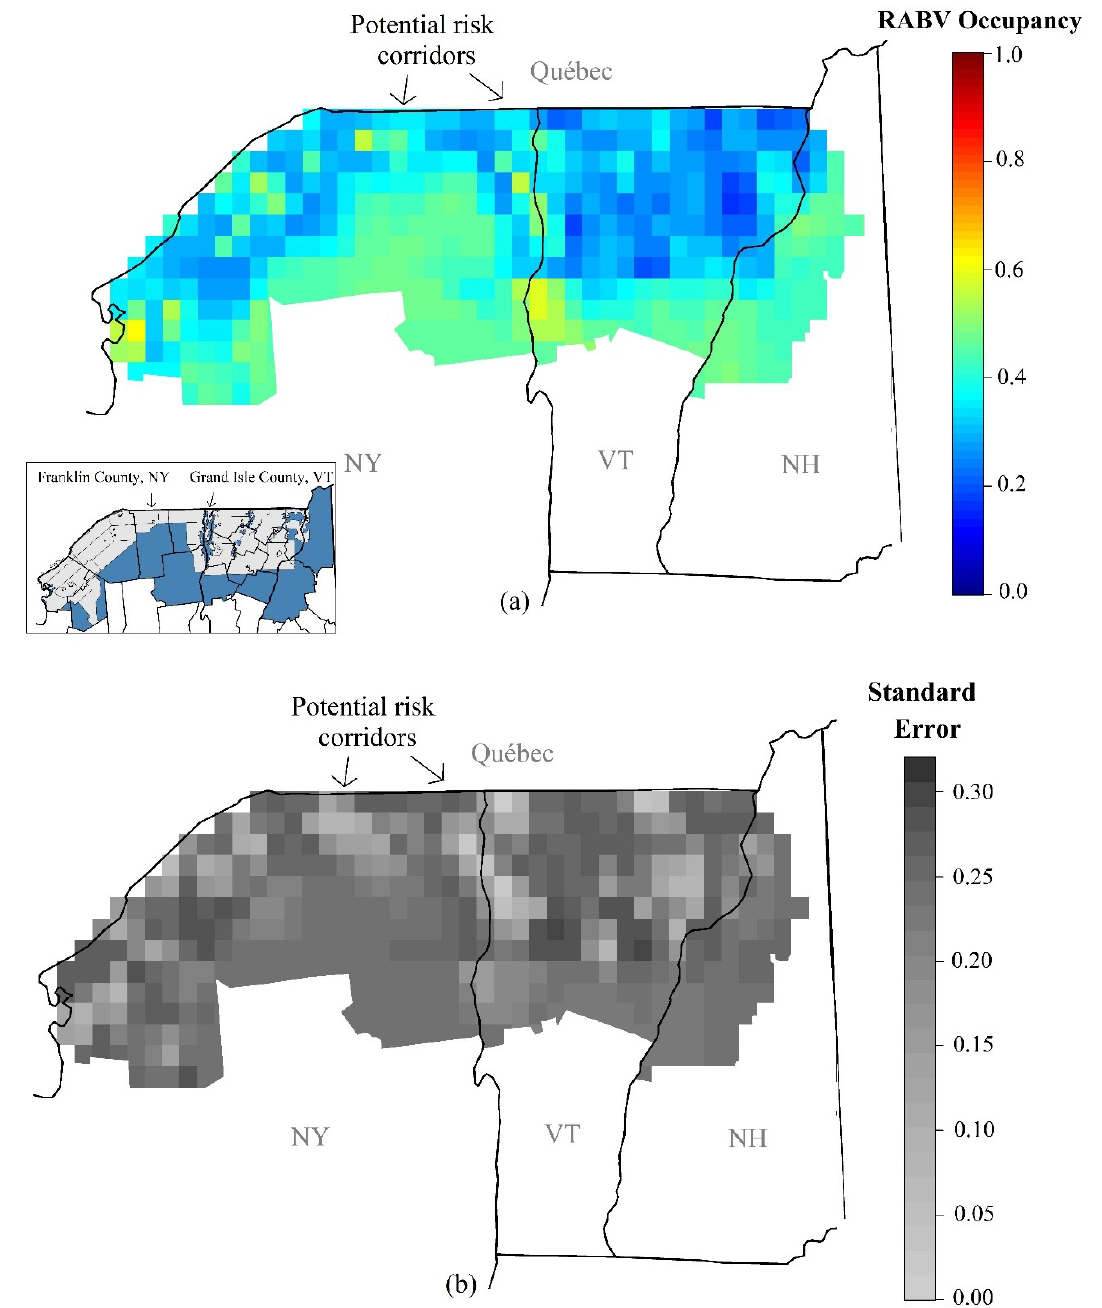
Figure 4. ( a ) The probability of RABV occupancy surface within the study area in the fall of 2017. The inset in this figure shows the county boundaries and the ORV boundaries for 2017 (light grey). ( b ) The standard error around RABV occupancy estimates by grid cell for the fall of 2017. Public health samples comprised the largest percent of all samples tested (30.75%, Table 2). Found dead and surveillance trapped were the smallest percentages of all samples (1.51% and 7.03% respectively, Table 2). The other surveillance methods ranged from 12% to 18% of all samples. Over